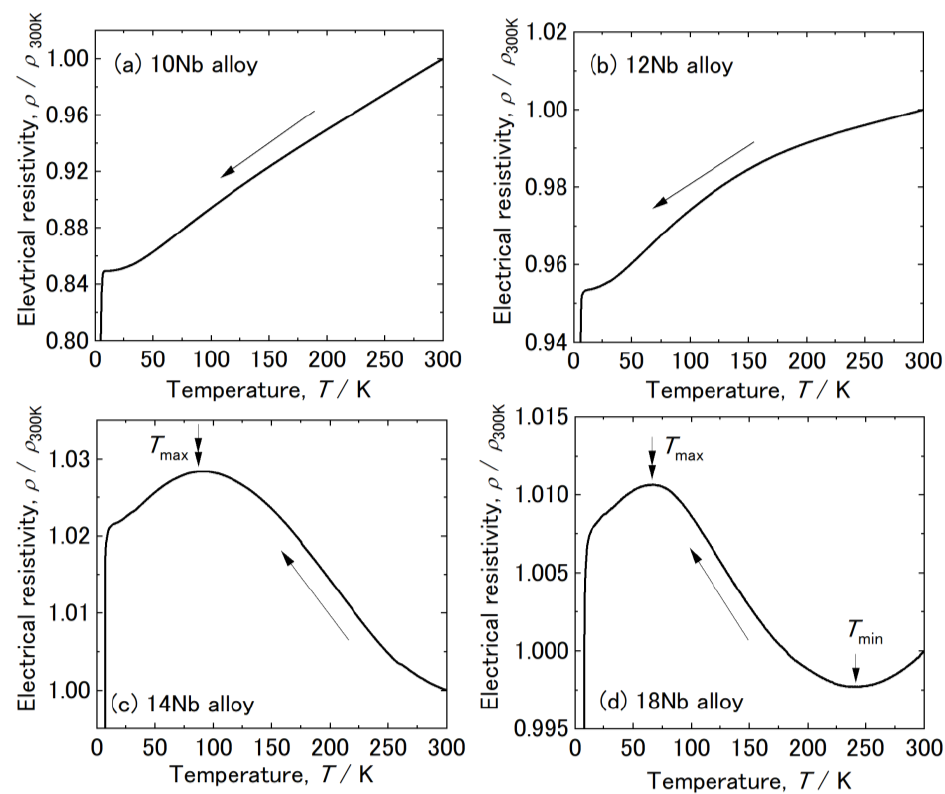
Figure 1. Electrical resistivity of various Zr-x at.% Nb alloys (x = 10, 12, 14, and 18) during the cooling process: ( a – d ) x = 10, 12, 14, and 18, respectively.